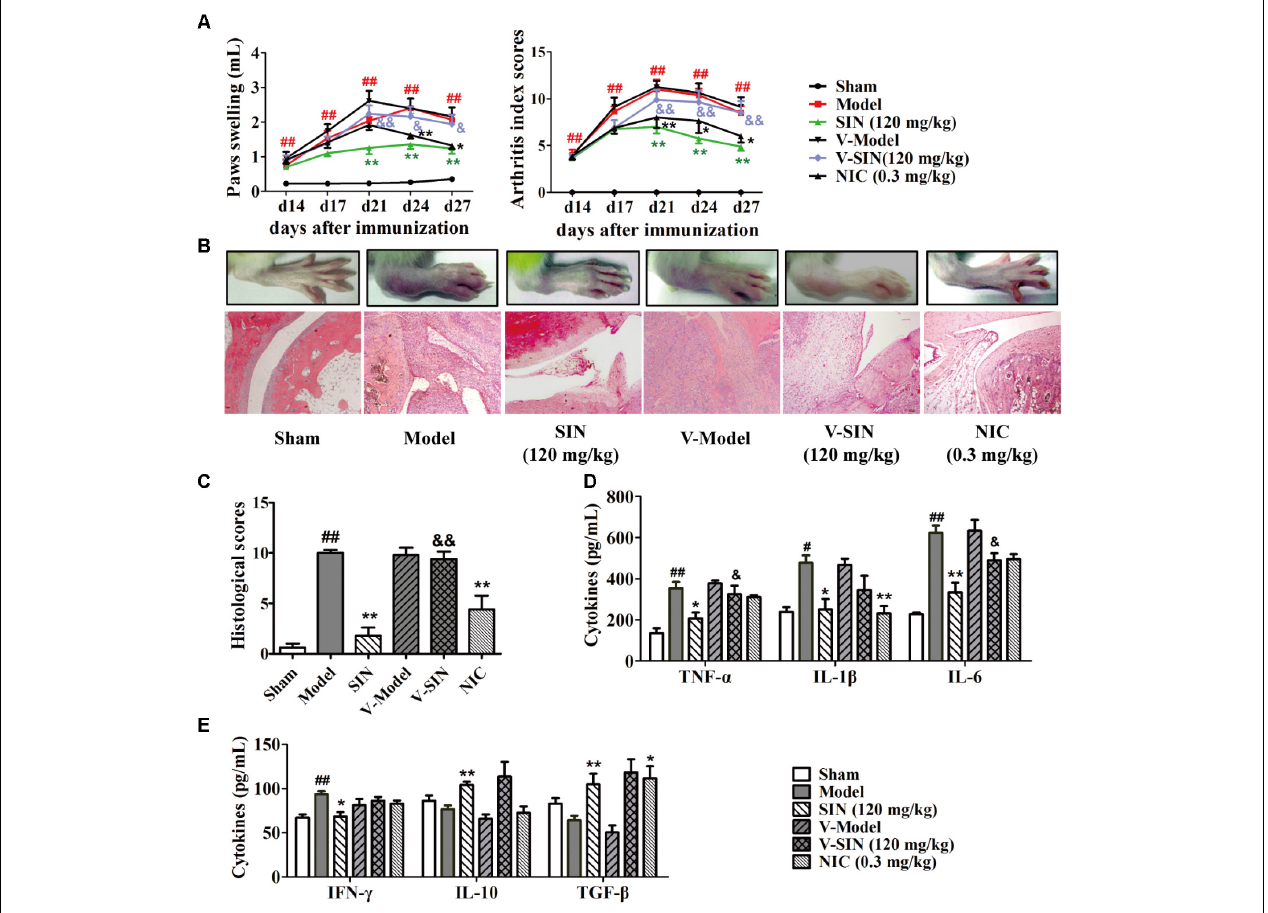
FIGURE 1 | Influence of vagotomy on the anti-arthritic effect of sinomenine (SIN). Rats were subjected to left cervical vagotomy or sham surgery 4 days before the induction of CIA. SIN was intragastrically administered daily for 2 weeks from day 14 to day 28. Nicotine (NIC), as positive control, was intraperitoneally injected from day 14 to 28. Rats in other groups were administered with an equal volume of vehicle during the treatment period. (A) The paw swelling and arthritis index were determined. (B) Photographs of representative hind paws were taken, and histopathological changes of right ankle joints in each group were determined by HE staining (original magnification 200 × ). (C) The histological scores of each group were calculated. (D) The serum levels of TNF- α , IL-1 β , and IL-6 were measured by ELISA. (E) The serum levels of IFN- γ , IL-10, and TGF- β were measured by ELISA. Data were expressed as means ± SEM, n = 6–8. F -values were 18.37 for paw swelling and 10.32 for arthritis index in (A) . # P < 0.05 and ## P < 0.01 versus Sham; ∗ P < 0.05 and ∗∗ P < 0.01 versus Model; & P < 0.05 and && P < 0.01 versus